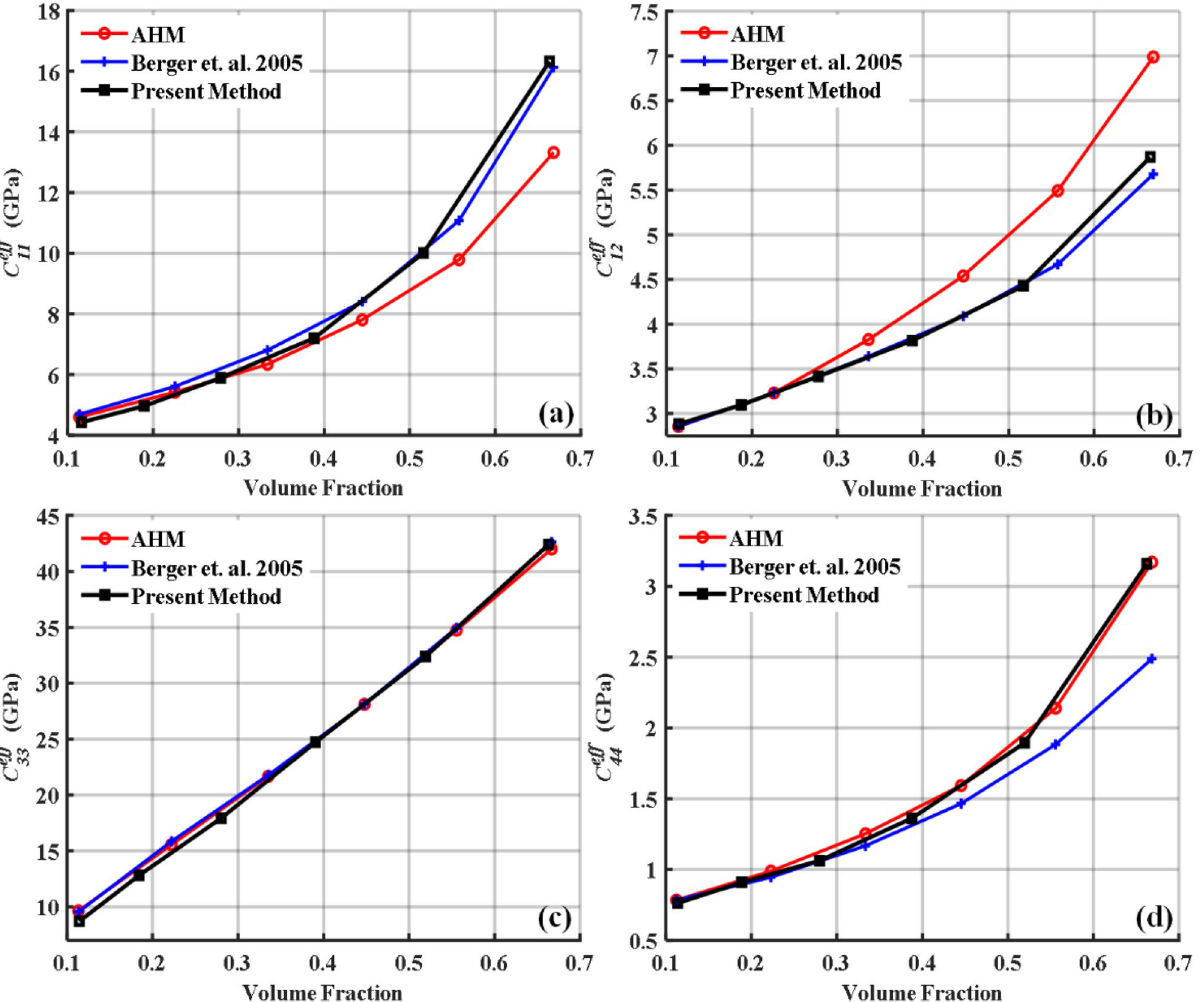
Figure 18. Validation of present model by comparing effective stiffness properties.